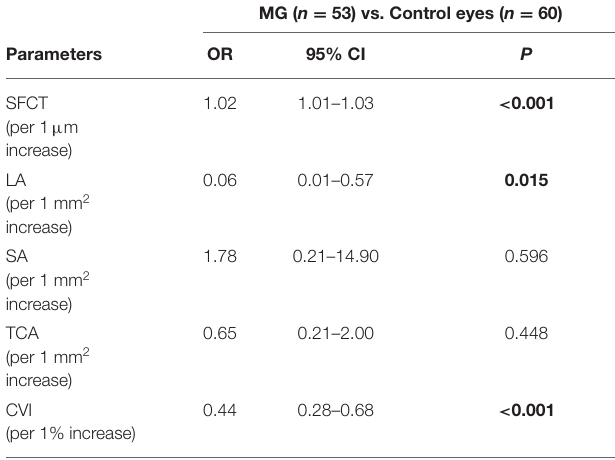
TABLE 2 | The Pearson correlations between the SFCT, the CVI, and demographic factors in recruited eyes. Parameters